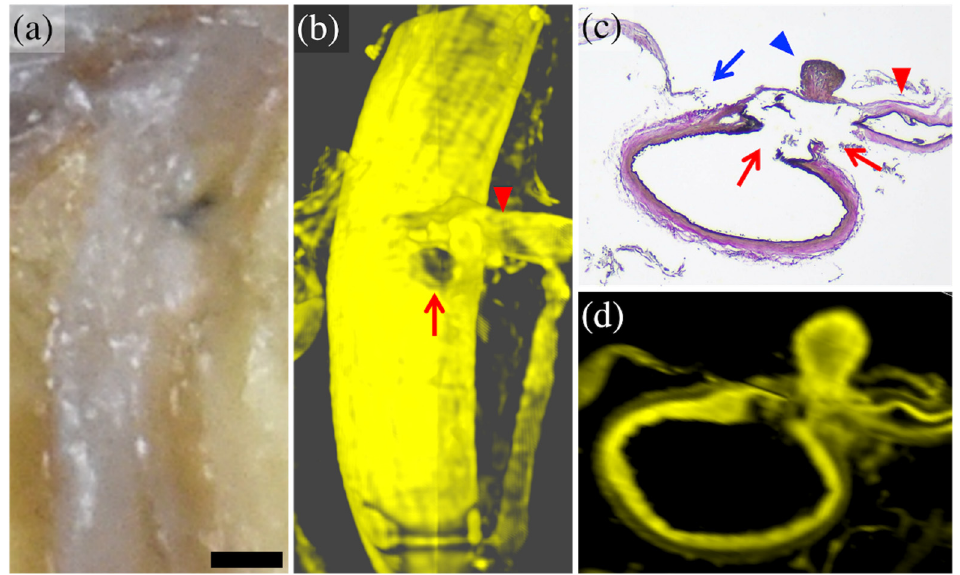
Figure 5. Comparison of macroscopic and histopathological images with CUBIC images in case 4. The enlarged macroscopic (formalin-fixed) image ( a ) did not reveal the presence of arterial rupture or a small arterial branch. The 3D-CUBIC image ( b ) clearly showed an arterial wall defect (arrow) at the base of a fine branch (arrowhead). The histopathological (Elastica van Gieson staining) image ( c ) showed the arterial rupture (red arrows) at the base of a fine arterial branch (red arrowhead) as well as a tear of the arachnoid (blue arrow) and a small nodule (blue arrowhead) near the rupture. The cross-sectional CUBIC image ( d ) reconstructed the morphology of the rupture, arachnoid tear and small nodule as shown by the histopathological image. The bar (on the lower right side of ( a )) is equal to 0.5 mm for ( a , b ) and 300 μ m for ( c , d ). The panel ( a ) is modified from the study by Funayama et al. [52].